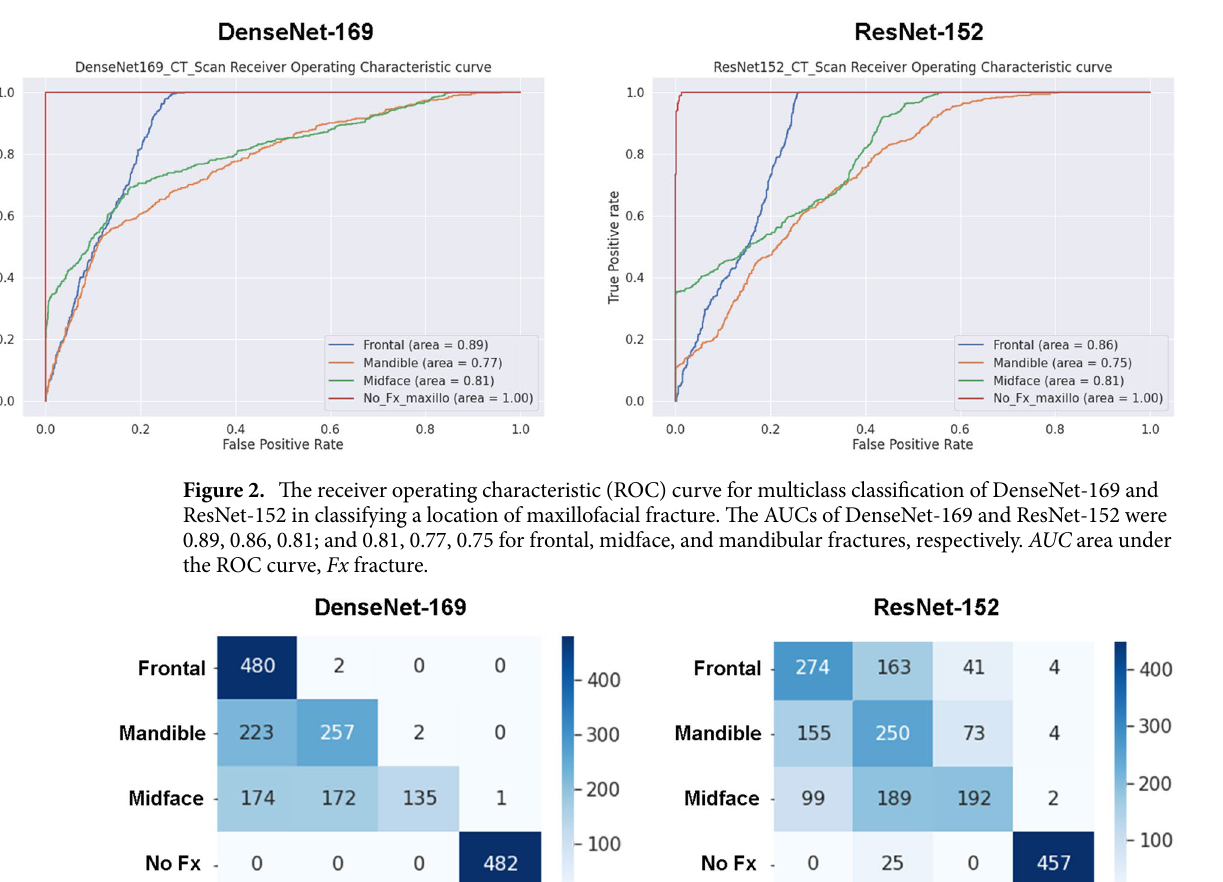
Figure 3. Normalized confusion matrix of multiclass classification of DenseNet-169 and ResNet-152. The y axis represents the true label, and the x axis represents the model’s prediction. Fx